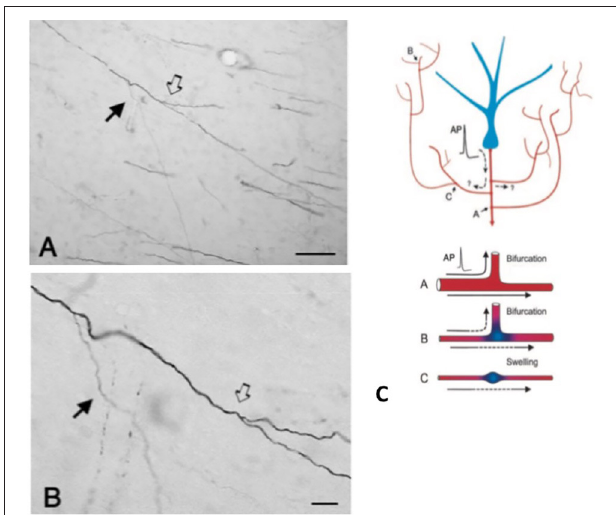
FIGURE 2 | A typically branched segment of axon in the white matter (macaque monkey). The segment originates from a neuron in parietal cortex and is seen here in the vicinity of ventral temporal cortex. Panel (A) is lower magnification of (B) . Note double bifurcations, where the first daughter branch (solid arrow) is conspicuously thinner (and unmyelinated?) than the main axon. In the second, slightly more distal bifurcation (hollow arrow), the daughter branches appear about equal in diameter, but both are thinner than the main axon. Scale bars = 100 µ m (A) and 10 µ m (B) . Reproduced from Zhong and Rockland (2003) with permission. (C) Schematic of a neuron (blue) and its extended branching topology (foreshortened for the sake of convenient formatting). An action potential (AP) can follow circuitous paths (A–C) to multiple targets. Reliability of propagation depends both on active electrical properties of the axon and its geometry, including membrane inhomogeneties such as swellings and incompatible branch diameters. Below: schematic to illustrate reliable propagation ( A , with optimal impedance matching between the mother and daughter branches), and slowed or failed propagation ( B , where the daughter branch has an enlarged diameter; C , where there is an interposed membrane swelling). Reproduced from Huguenard (2000) with